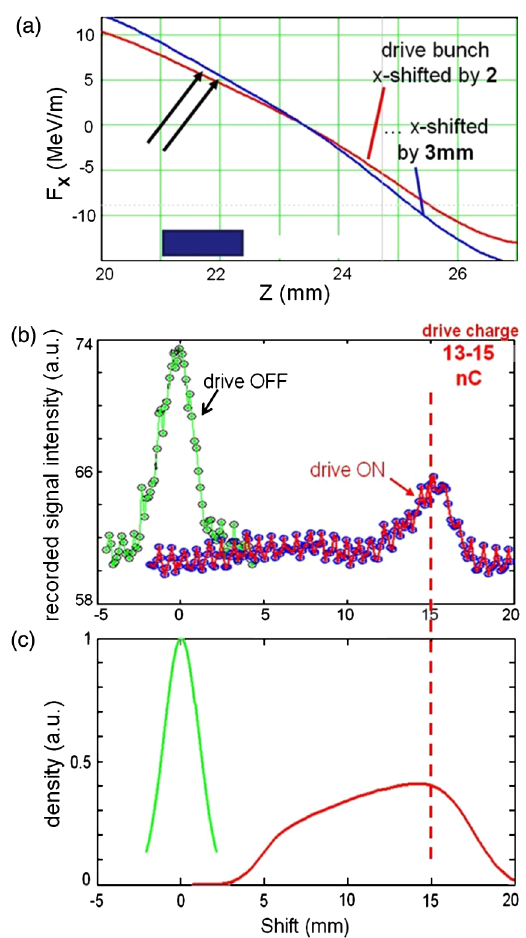
FIG. 17. (a) Simulations of F x for the test channel. (b) Typical bunch horizontal distribution (observed in 80% of shots) when the delay was 21.7 mm; note that these are examples of ‘‘raw’’ distributions. (c) Changes in horizontal distribution [for case #3 in Tables V and VI with the drive bunch being shifted off the center of its respective channel by 2 mm (toward the test